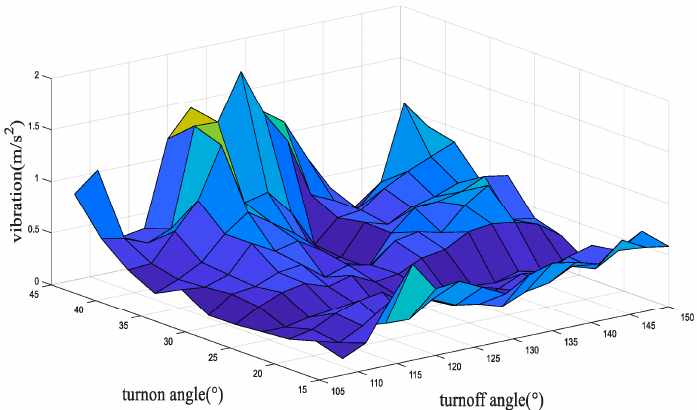
Figure 11. The 2nd vibration under different turn-on (15–45°) and turn-off (125–145°) angles.